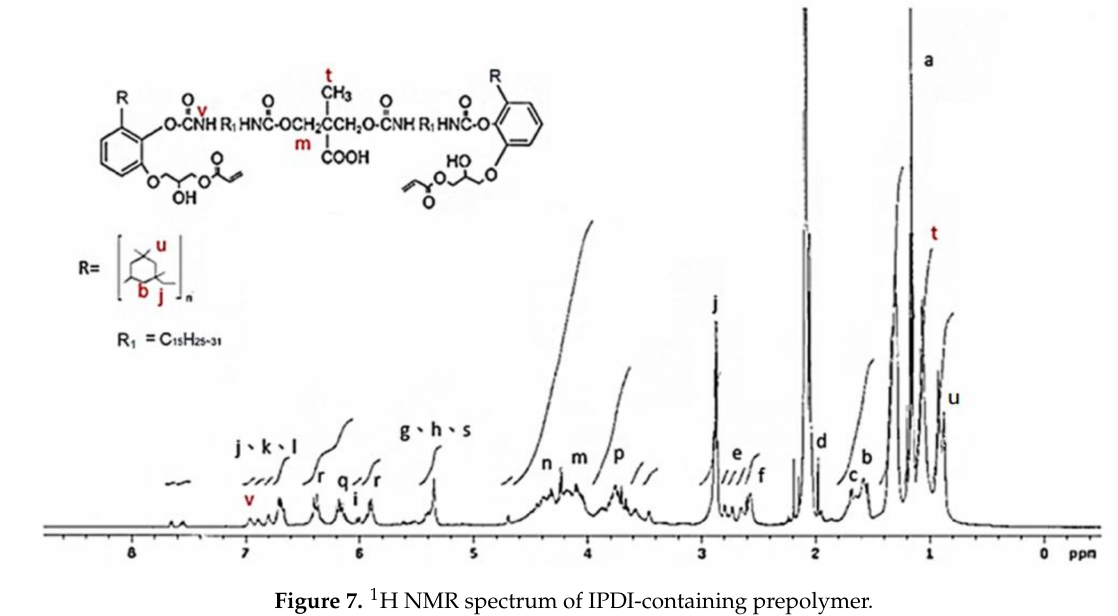
Figure 7. 1 H NMR spectrum of IPDI-containing prepolymer.